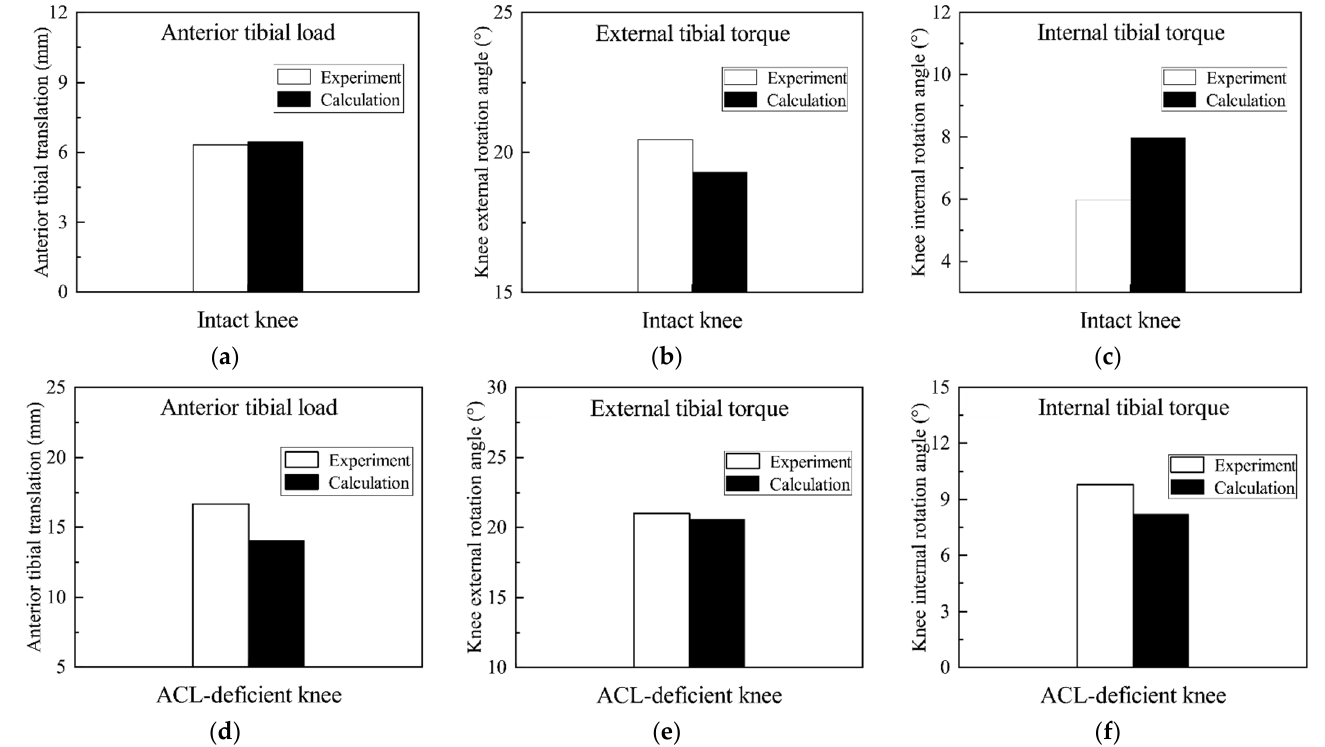
Figure 4. Comparison of the specimen experimental and finite element model results: ( a ) Anterior tibial translation under anterior tibial load in the intact knee; ( b ) Knee external rotation angle under external tibial torque in the intact knee; ( c ) Knee internal rotation angle under internal tibial torque in the intact knee; ( d ) Anterior tibial translation under anterior tibial load in the ACL-deficient knee; ( e ) Knee external rotation angle under external tibial torque in the ACL-deficient knee; ( f ) Knee internal rotation angle under internal tibial torque in the ACL-deficient